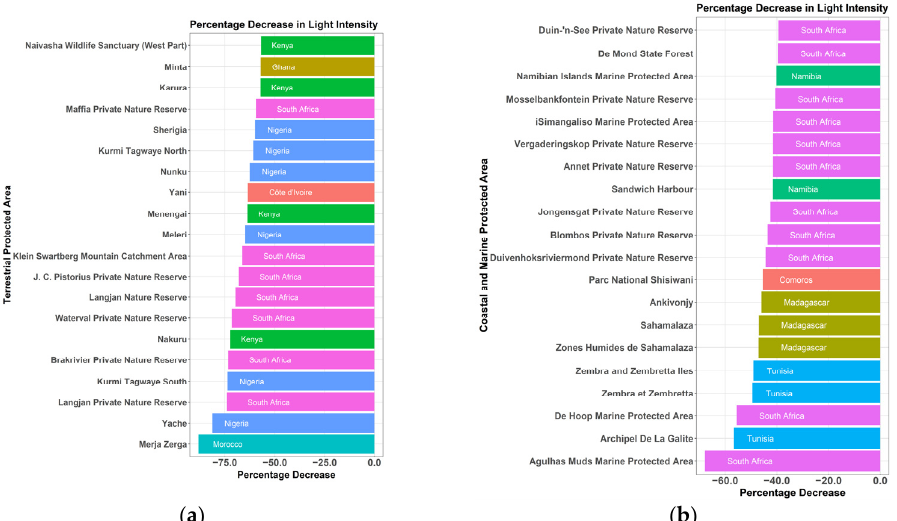
Figure A2. ( a ) Percentage decrease in light intensity in Terrestrial PAs with the highest decrease in the light intensity; ( b ) percentage decrease in light intensity in coastal and marine PAs with the highest decrease in the light intensity.